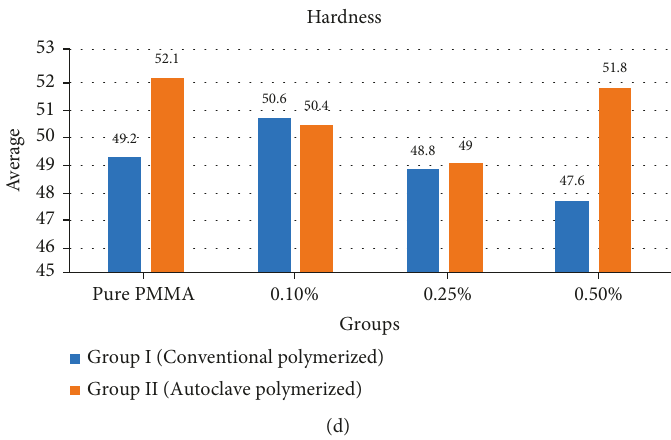
Figure 5: (a) Flexural strength, (b) elastic modulus, (c) impact strength, and (d) hardness of the tested